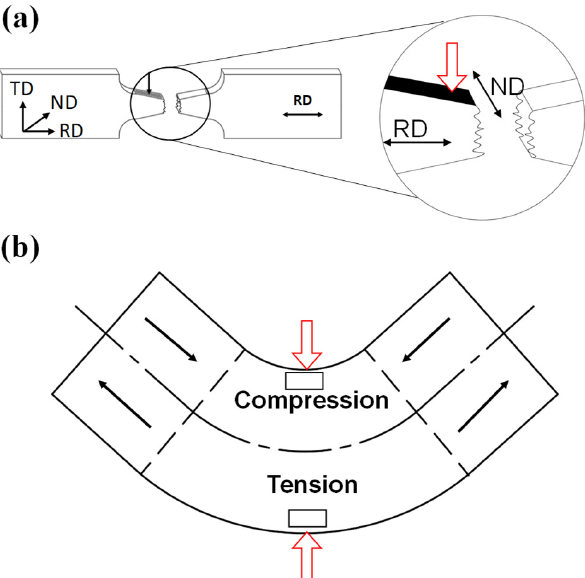
Figure 5. Microstructure observation region in ( a ) the stress relaxation specimen and ( b ) the bending specimen.